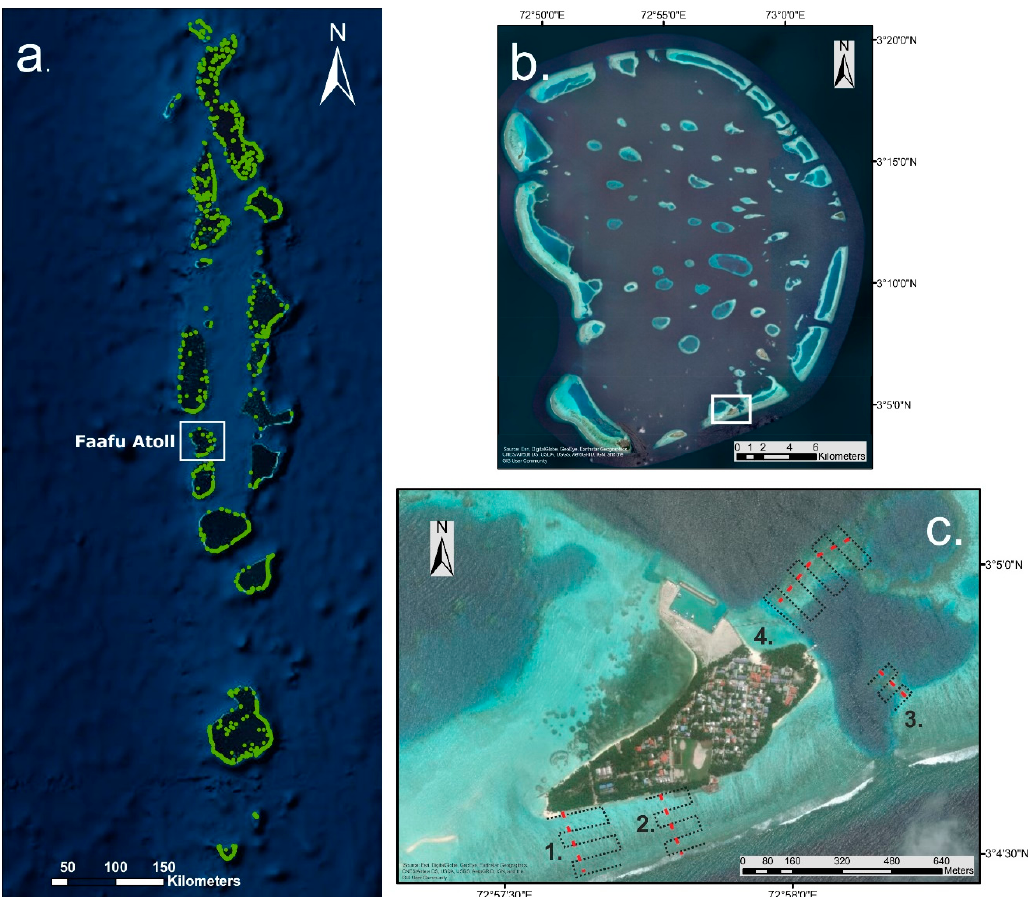
Figure 1. ( a ) Geographic location of the study area, Republic of Maldives; ( b ) Faafu Atoll. ( c ) The four monitored reef areas around Magoodhoo island: black dotted lines indicate the approximate extent of the UAV-surveyed areas and the flight paths; red dashed lines indicate the snorkeling transects.